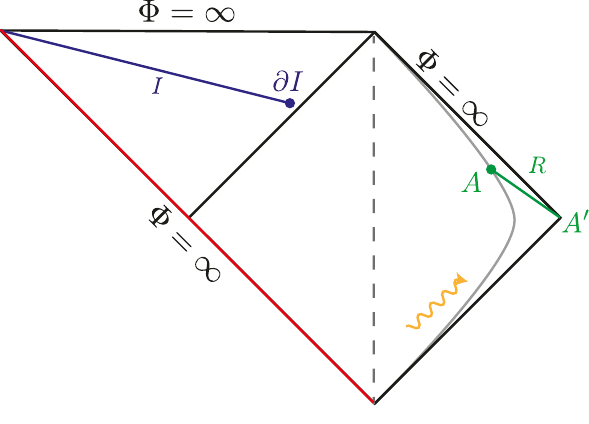
Figure 5 . Using the formula for the fine-grained entropy, we compute the entropy S ( R ) of a weakly-gravitating region R = [ A, A 0 ] which contains radiation emanating from the past horizon. Because the radiation is entangled with the region beyond the future horizon, we allow for a possible island I that contributes to S ( R )